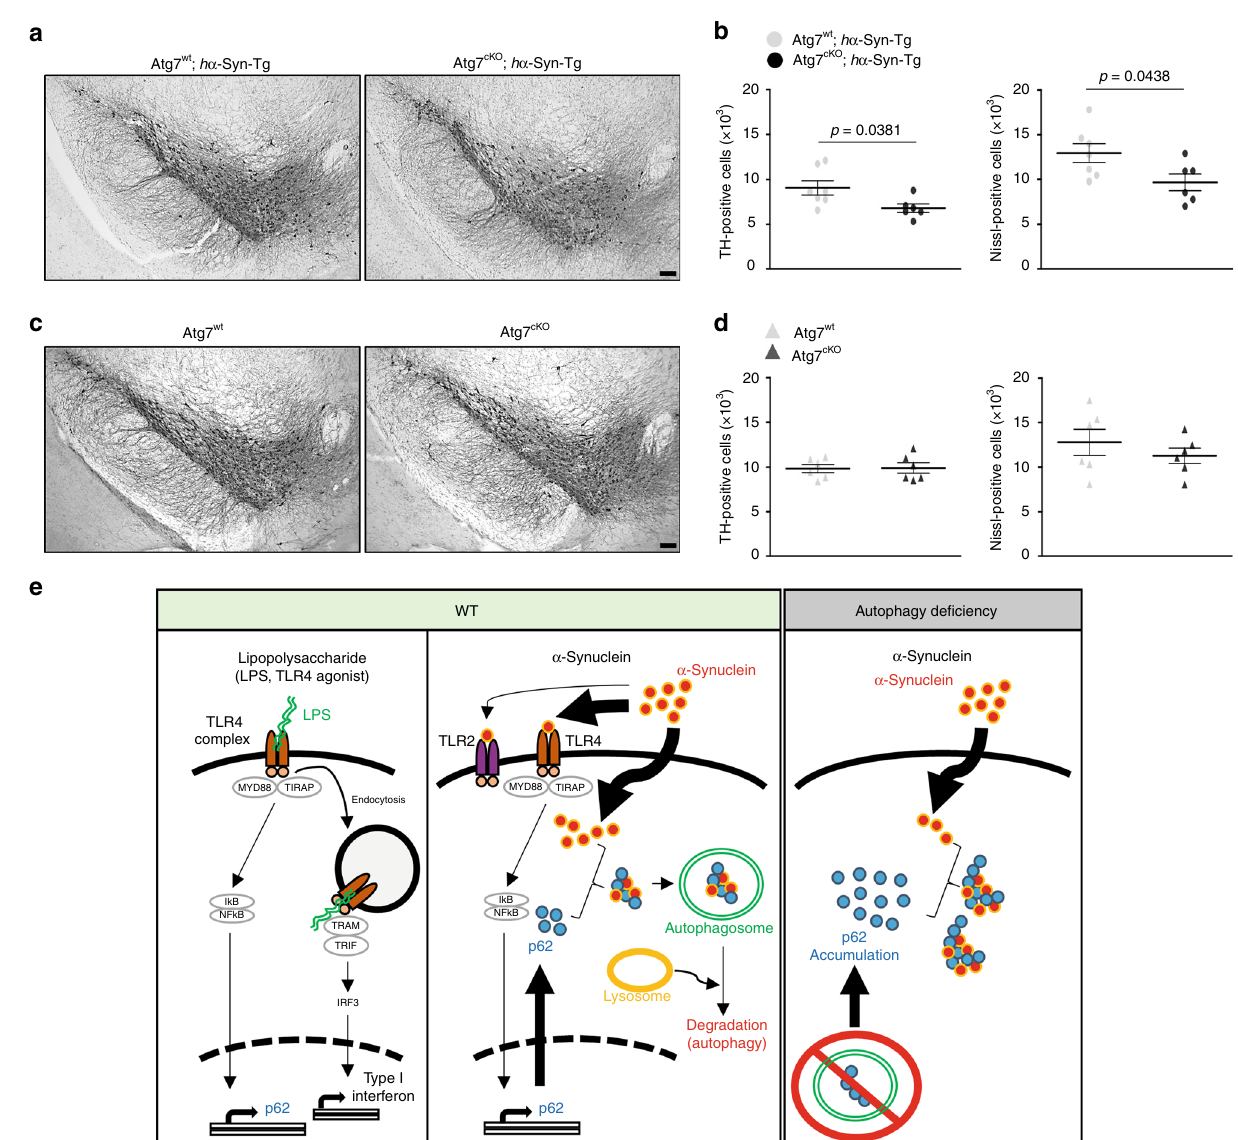
Fig. 7 Autophagy-de fi cient microglia promote neurodegeneration. a , b At 7 months after tamoxifen treatment, brains from Atg7 fl ox/ fl ox ; h α -Syn-Tg mice ( n = 7) and Cx3cr1 CreER-IRES-Eyfp ; Atg7 fl ox/ fl ox ; h α -Syn-Tg mice ( n = 6) were fi xed and stained using an antibody against tyrosine hydroxylase (TH) using DAB method ( a ). TH-positive cells and Nissl-positive cells in the SNpc area were counted ( b ). p -values were calculated by unpaired two-tailed Student ’ s t test. Scale bar, 100 µ m. c , d At 12 months after tamoxifen treatment, TH-positive cells and Nissl-positive cells were counted in SNpc area of Atg7 fl ox/ fl ox ( n = 6) and Cx3cr1 CreER-IRES-Eyfp ; Atg7 fl ox/ fl ox ( n = 6) brains. e Hypothetical model of microglial synucleinphagy. All values are reported as mean ±